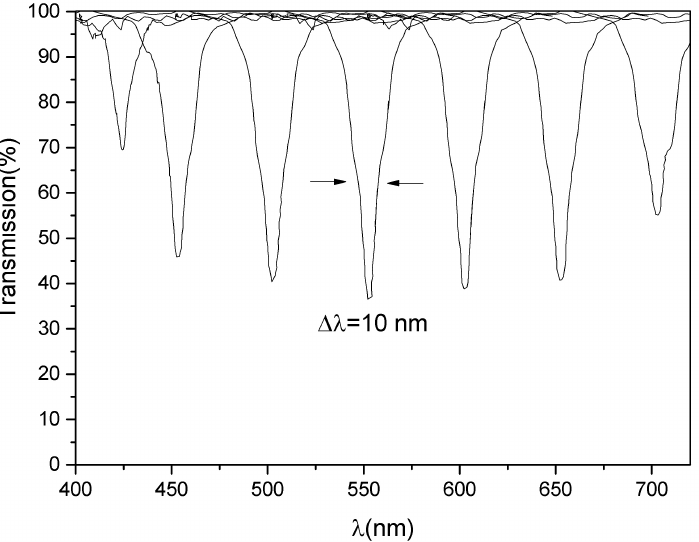
Figure 4. Spectra of a transmission grating taken at different diffraction angles (53.4 ◦ , 51.0 ◦ , 45.4 ◦ , 39.4 ◦ , 32.6 ◦ , 24.1 ◦ , 10.7 ◦ ). The maximum measured value of diffraction efficiency is >60% with a FWHM of ≈ 10 nm, grating pitch Λ ≈ 230